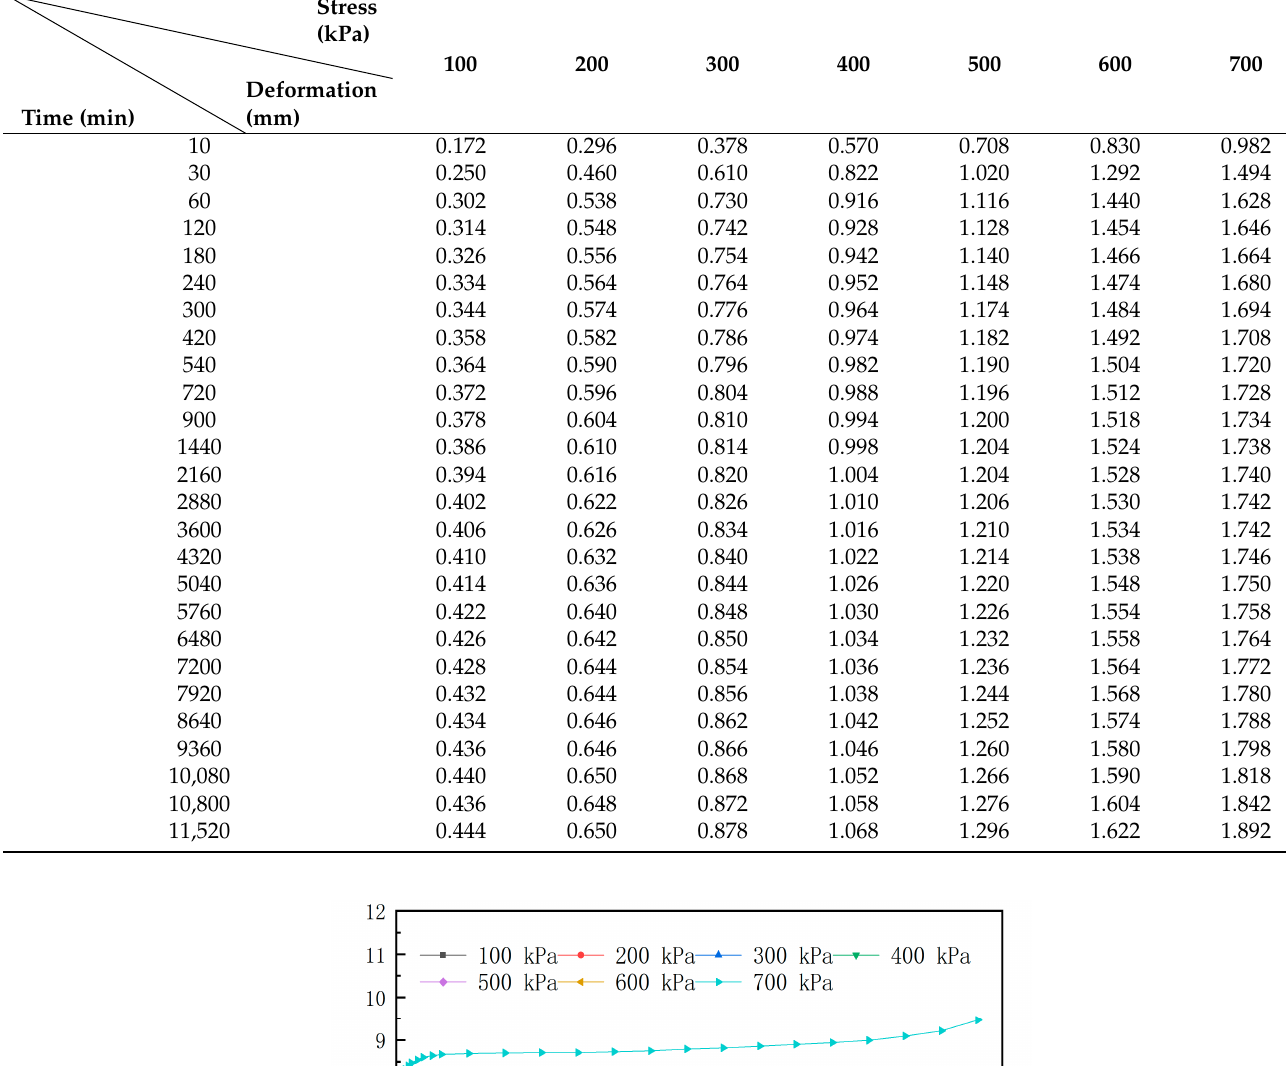
Table 3. Test results of sandy soil.